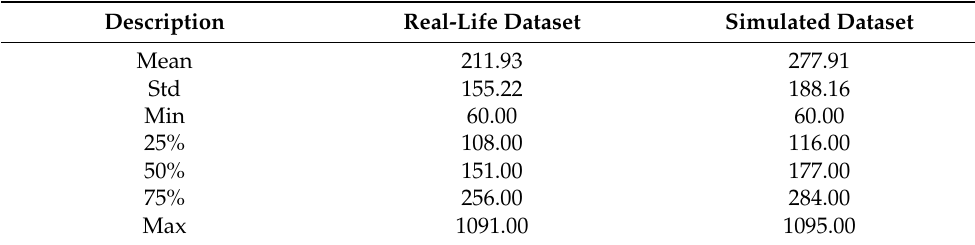
Table 1. The series lengths of real-life datasets and simulated